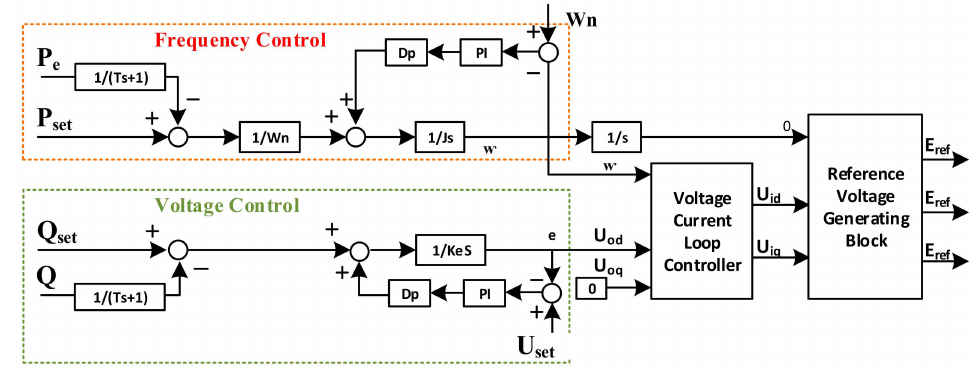
Figure 10. Voltage and frequency control block diagram [83].